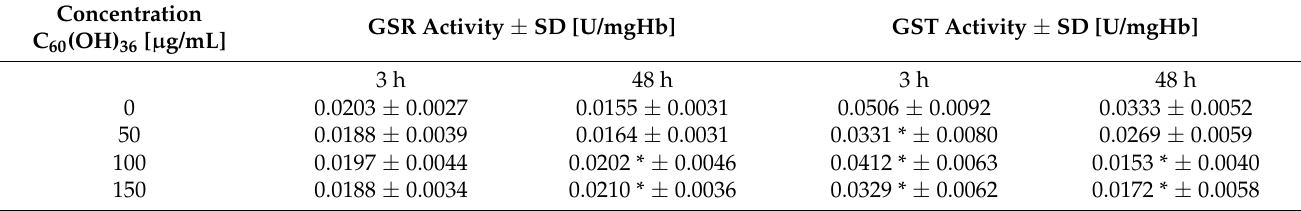
Figure 2. ( A ) Effect of C 60 (OH) 36 on the activity of glutathione reductase. Measurements were made after 3 and 48 h of incubation with C 60 (OH) 36 at a concentration of 0, 50, 100, and 150 µ g/mL at 37 ◦ C. The bars represent the mean values ± SD for 3 independent measurements. * Statistically significant values relative to controls after 48 h of incubation at p < 0.05. ( B ) Effect of C 60 (OH) 36 on the activity of glutathione transferase. Measurements were made after 3 and 48 h of incubation with C 60 (OH) 36 at a concentration of 0, 50, 100, and 150 µ g/mL at 37 ◦ C. The bars represent the mean values ± SD for 3 independent measurements. * Statistically significant values relative to controls after 3 and 48 h of incubation at p < 0.05. Table 3. Glutathione reductase and glutathione transferase activity converted to 1 mg of hemoglobin protein in the suspension of erythrocytes incubated with C 60 (OH) 36 in the concentration range of 0–150 µ g/mL for 3 and 48 h at 37 ◦ C. After incubation, the erythrocytes were subjected to